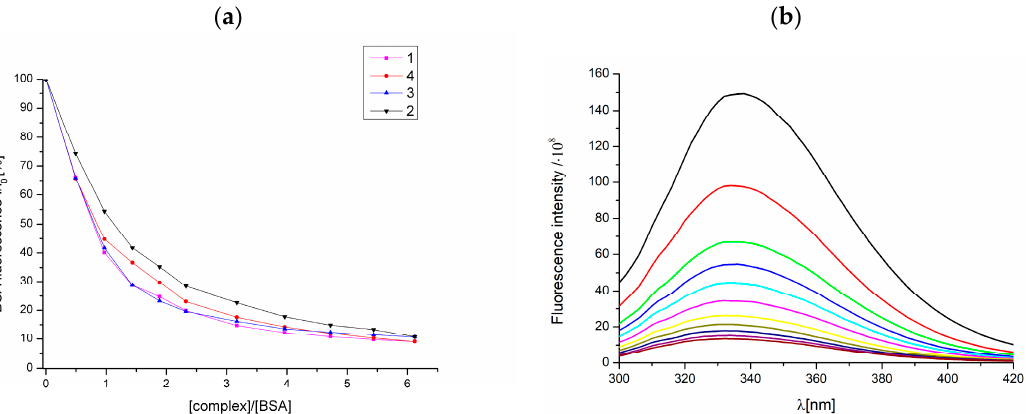
Figure 12. ( a ) Graphical dependence of relative BSA fluorescence intensity in % at λ = 336 nm vs. concentration ratio [complex]/BSA. ( b ) Fluorescence emission spectra for EB-DNA in the buffer solution in the presence of increasing amounts of 4 .